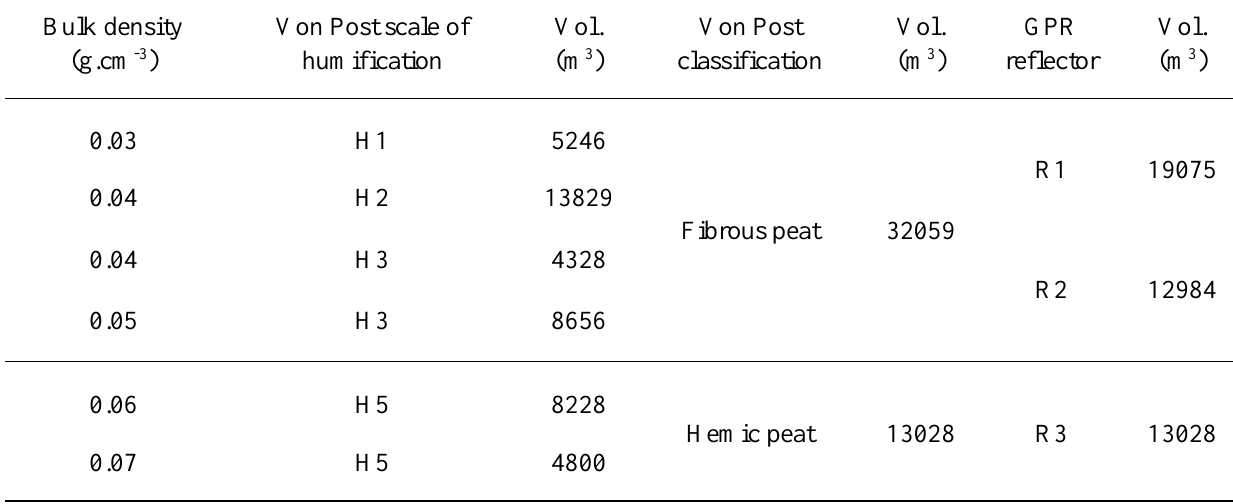
Table 1. Estimated values from the tridimensional models, for the peat layers identified in Peat Bog IV. Bulk